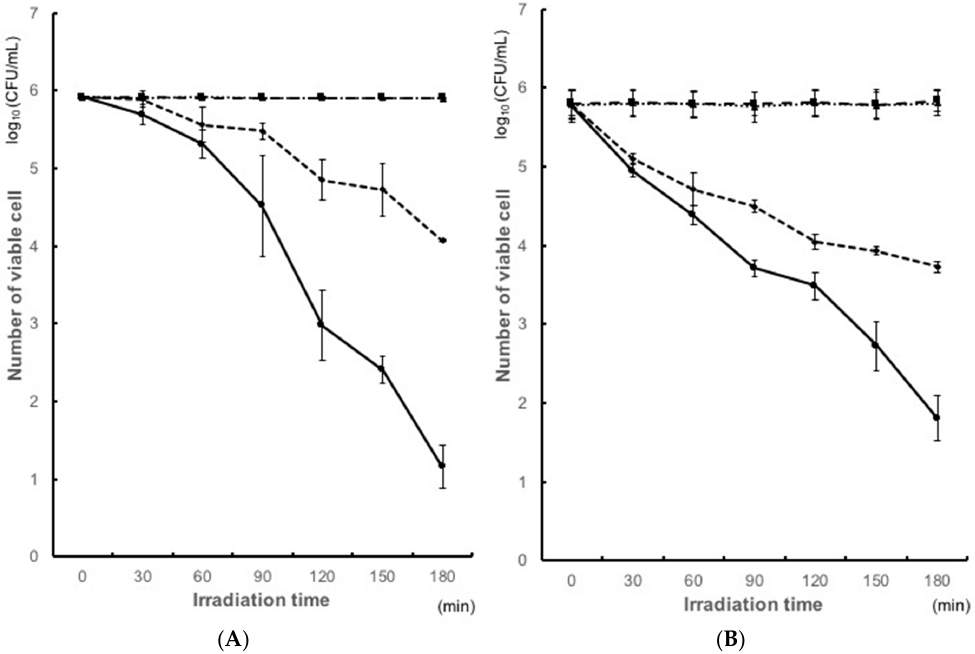
Figure 1. Antibacterial effects of TiO 2 photocatalysis against ( A ) Streptococcus gordonii ; ( B ) Streptococcus oralis ATCC.